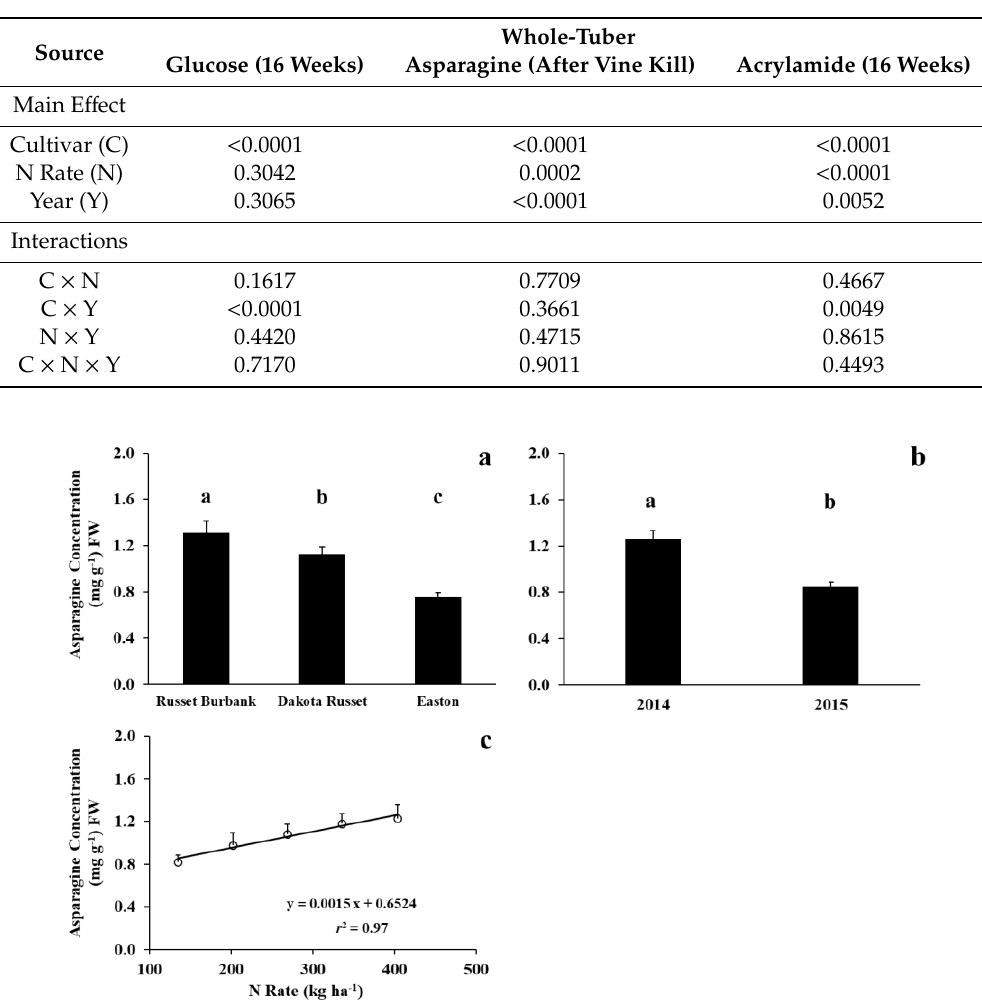
Table 2. The analysis of variance for the concentrations of glucose, asparagine, and acrylamide in 2014 and 2015.